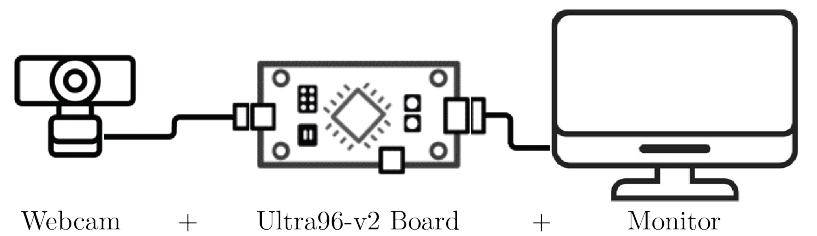
Figure 1. Device connection scheme of the circle detection system.